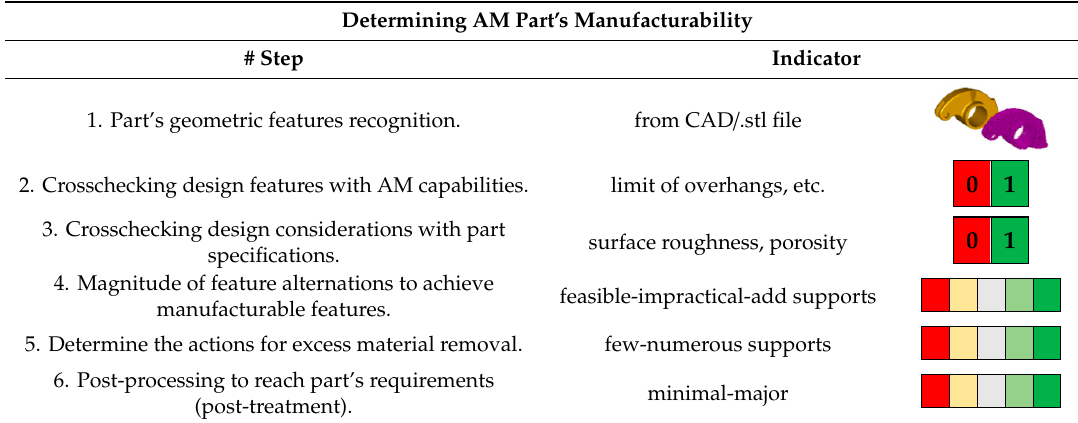
Table 3. Framework of the AM manufacturability determination.